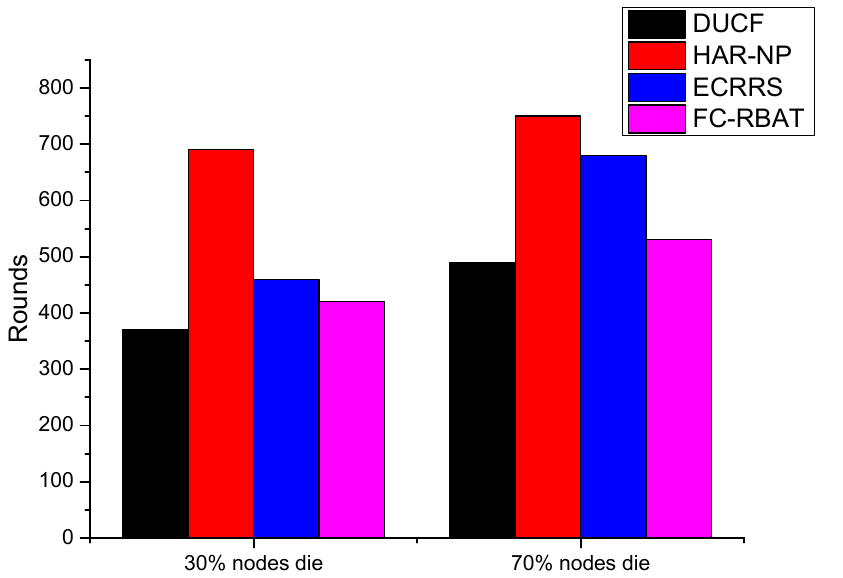
Figure 3. Comparison of the 30% and 70% node death times of the four algorithms.